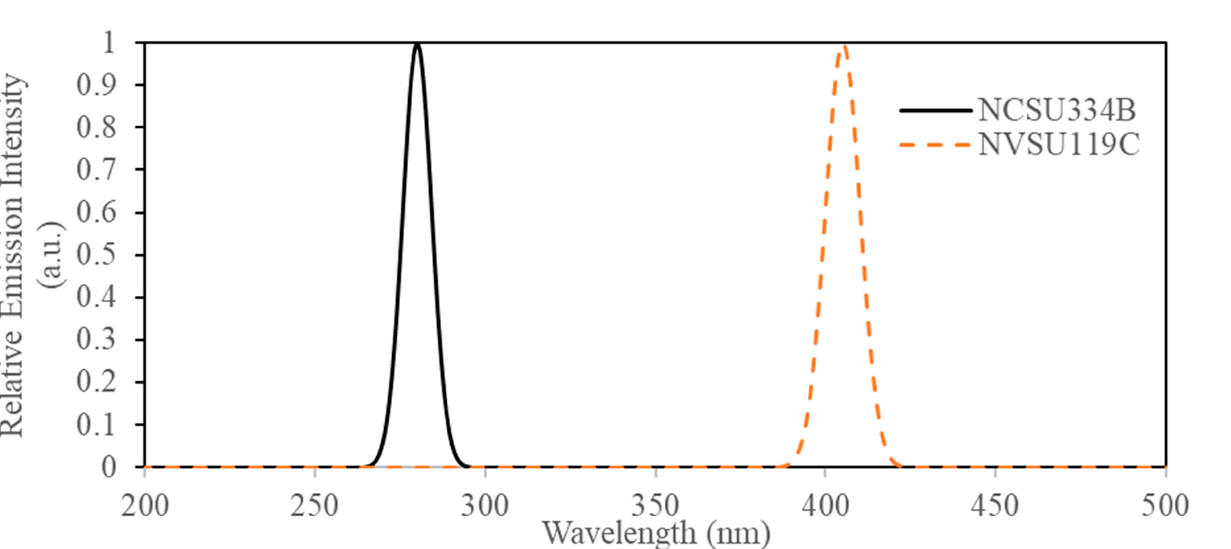
Table 1. Specifications of LED (obtained from Nichia Corporation).